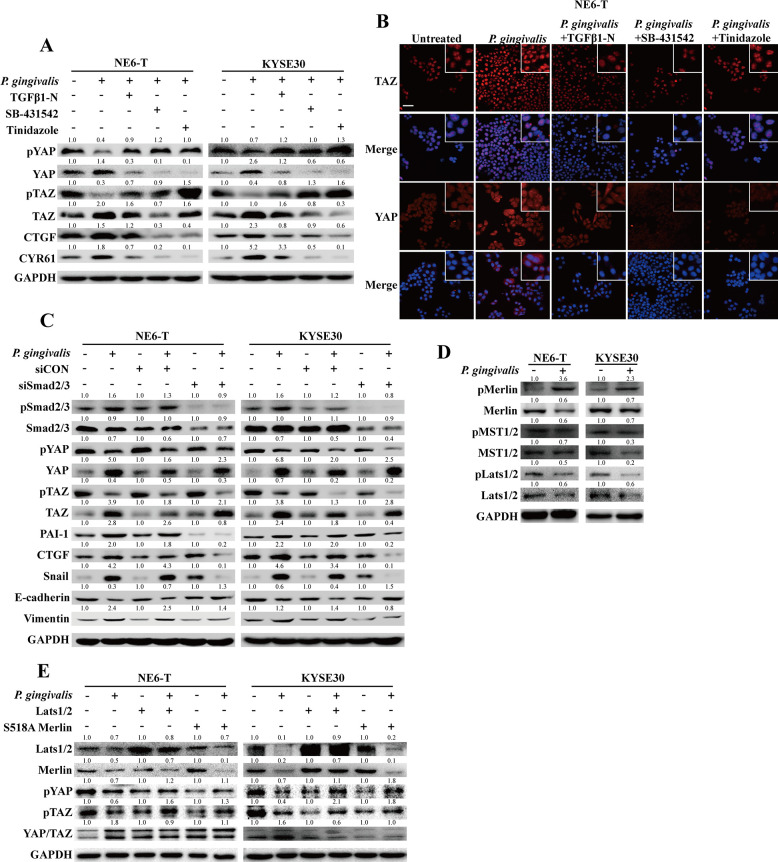
P. gingivalis activates YAP/TAZ through TGFβ noncanonical signaling in ESCC cells.(A) Indicated proteins were detected by western blot in NE6-T and KYSE30 cells with different treatments. (B) Subcellular localization of YAP/TAZ was detected by immunofluorescence microscopy in NE6-T cells with different treatments. Scale bar, 50 μm. (C) NE6-T and KYSE30 cells were transfected with control siRNA or siRNA targeting Smad2/3 and then treated with P. gingivalis. Western blots were used to detect the indicated protein levels in NE6-T and KYSE30 cells with different treatments. (D) NE6-T and KYSE30 cells were treated with PBS control or P. gingivalis for 24 h. Hippo pathway components pLats1/2, pMst1/2, and pMerlin, together with their total levels, were detected by western blots. (E) NE6-T and KYSE30 cells were transfected with control plasmid, Lats1/2, or Merlin S51A mutant expression plasmids and then were treated with P. gingivalis. Western blots were used to detect the indicated protein levels in NE6-T and KYSE30 cells with different treatments. Representatives of 3 independent experiments. CTGF, connective tissue growth factor; ESCC, esophageal squamous cell carcinoma; GAPDH, glyceraldehyde-3-phosphate dehydrogenase; Lats, large tumor suppressor homolog; Merlin, moesin-ezrin-radixin-like protein; Mst, mammalian STE20-like protein kinase; PAI-1, plasminogen activator inhibitor-1; PBS, phosphate-buffered saline; pLats, phosphorylated Lats; pMst, phosphorylated Mst; pMerlin, phosphorylated Merlin; siCON, scramble control for short interfering RNA; siRNA, short interfering RNA; Smad, Drosophila mothers against decapentaplegic homolog; TAZ, Transcriptional coactivator with PDZ-binding motif; TGFβ, transforming growth factor-β; TGFβ1-N, TGFβ1 neutralizing antibody; YAP, Yes-associated protein.